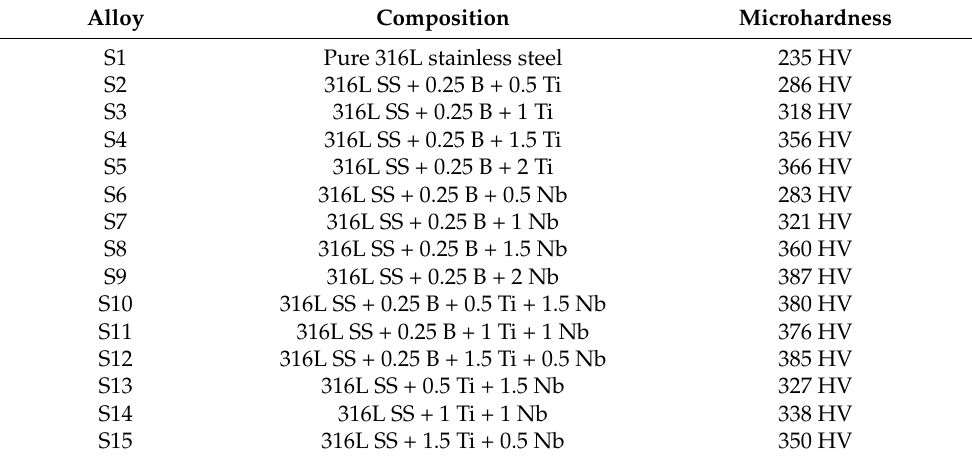
Table 4. Microhardness of all